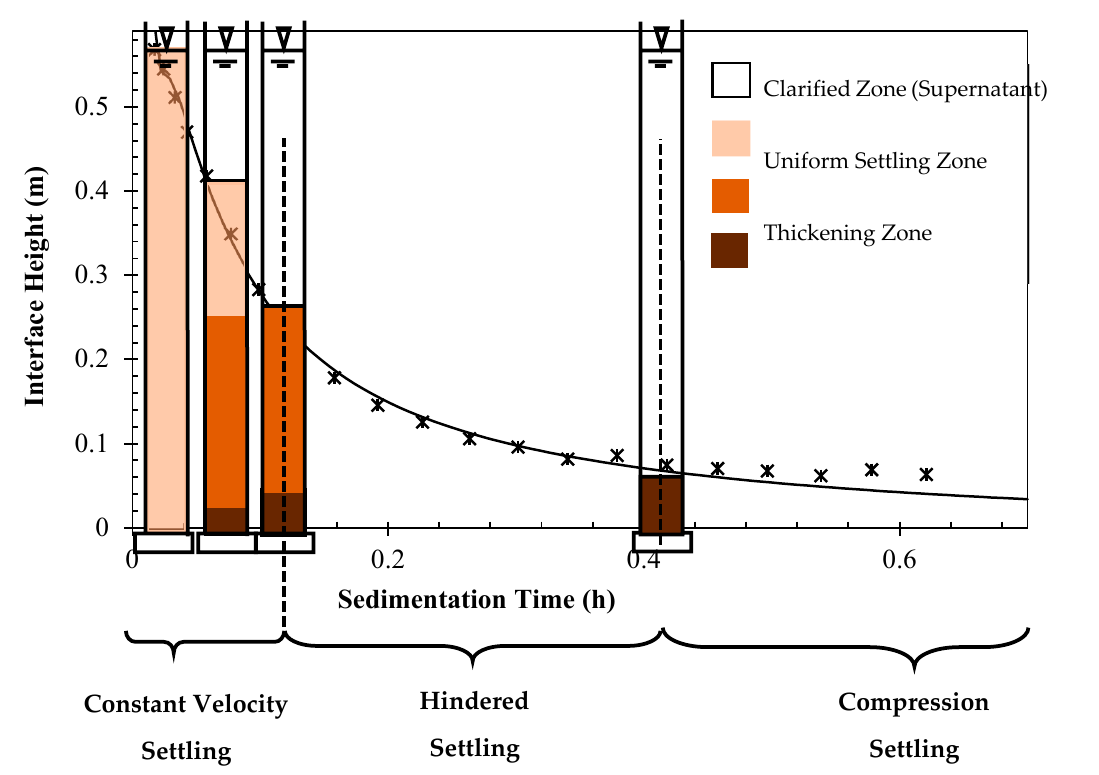
Figure 5. Different solids settling sections and clarity zones in a typical batch settling column test with initial sludge concentration of 5 g/L.